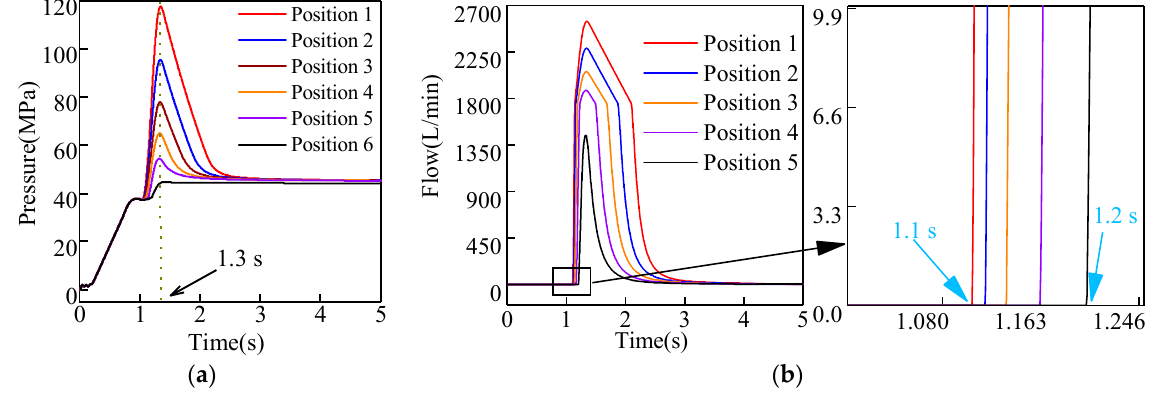
Figure 9. ( a ) Pressure of the lower chamber of the column at different rotation positions. ( b ) Flow of the lower chamber of the column at different rotation positions.